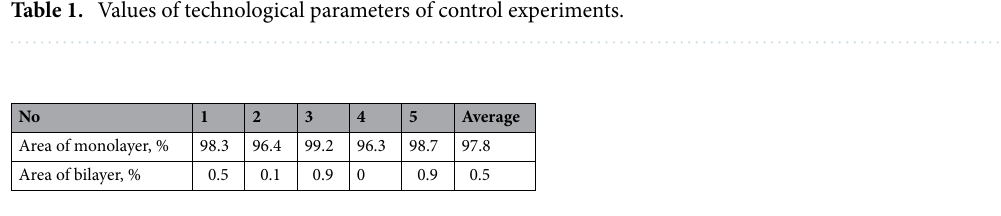
Table 2. Coverage areas with mono- and bilayers in control